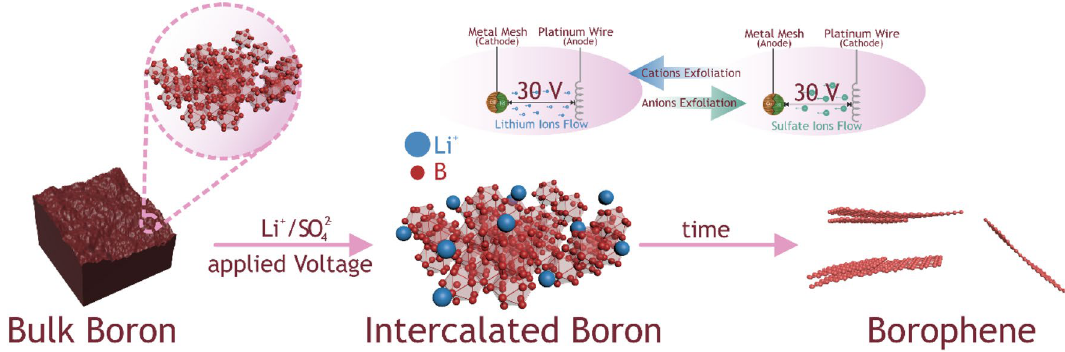
Figure 5. Proposed mechanism of bulk boron exfoliation to few-layered borophene